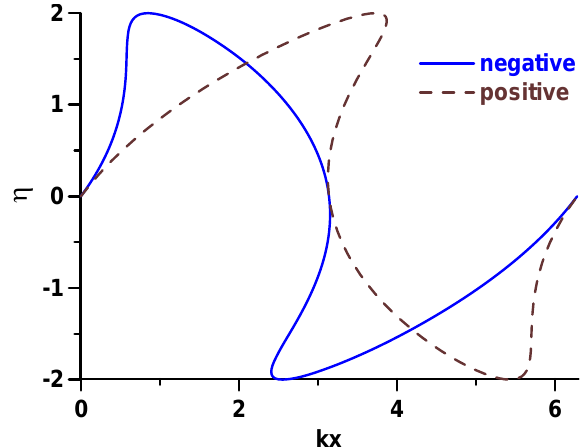
Fig. 4. Nonlinear wave deformation in the case of positive sign of the cubic nonlinearity. (a) : CQ = A = 0 . 4, and (b) CQ = A = 2. Fig. 5 demonstrates the different character of the nonlinear wave deformation for positive and Numbers – different times. negative sign of the cubic nonlinearity. In the latter case breaking occurs on back-slope of the wave shape.